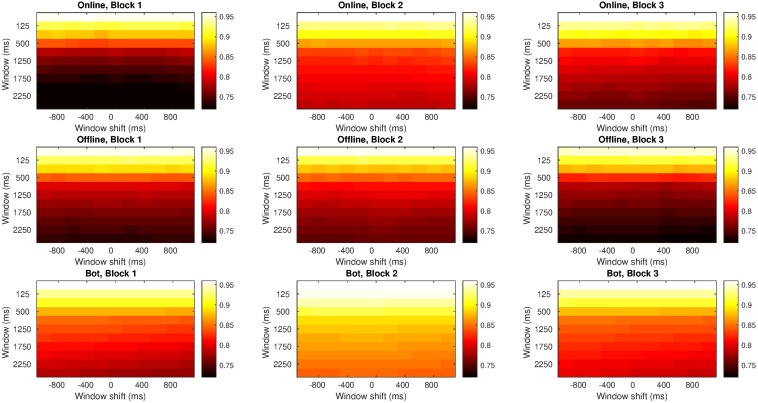
Correlation indices for different windows span and delay times in Study 1. Each row refers to a type of agent (human online, human offline and oscillatory bot) and each column refers to either block 1, block 2, or block 3. Inside each graph, the horizontal axis is the delay applied (from –1 s to 1 s), with the central column showing no delay at all. Vertical axis alludes to the window span, from 50 ms (at the top) to 2500 ms (at the bottom). Light colors indicate higher correlation and dark colors indicate lower correlation. All the graphs show the same scale of colors; then, colors can be compared among graphs.